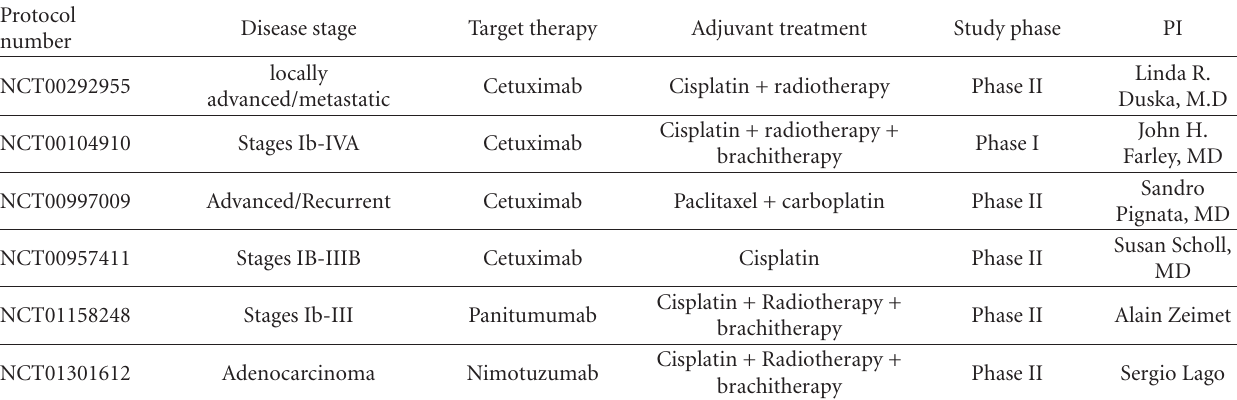
Table 4: Ongoing treatment studies evaluating VEGF MoAbs in cervical cancer